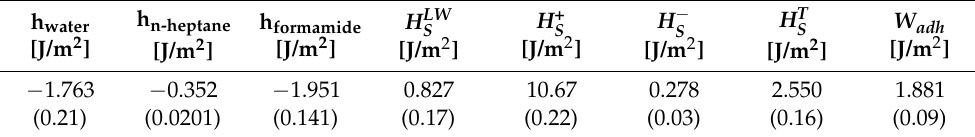
Table 1. The surface energy components, and the work of adhesion, W adh , of Fe-foam to water.